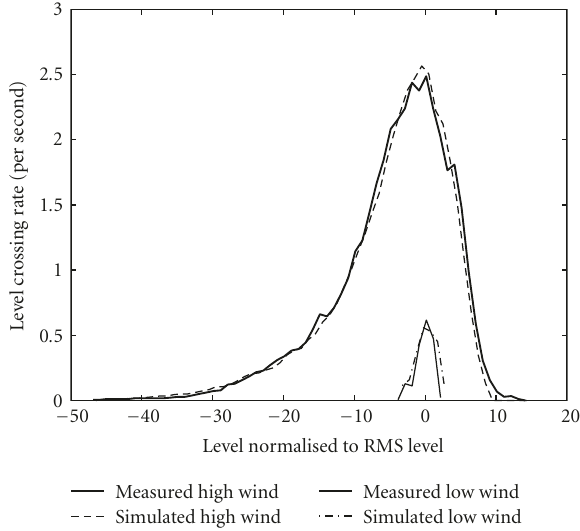
Figure 13: LCRs of measured (dry leaved deciduous trees (Site 1)) and simulated (using the new model) signals at 29 GHz during low ( w m = 2m/s) and high ( w m = 5 m/s) wind speed conditions. All simulation parameters are given in Table 3.